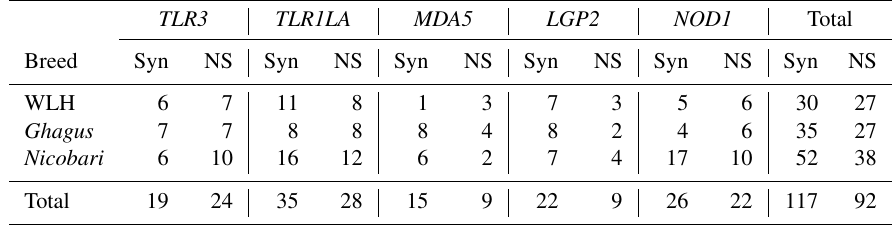
Table 1. Number of SNPs in the PRR genes in three breeds of chicken.